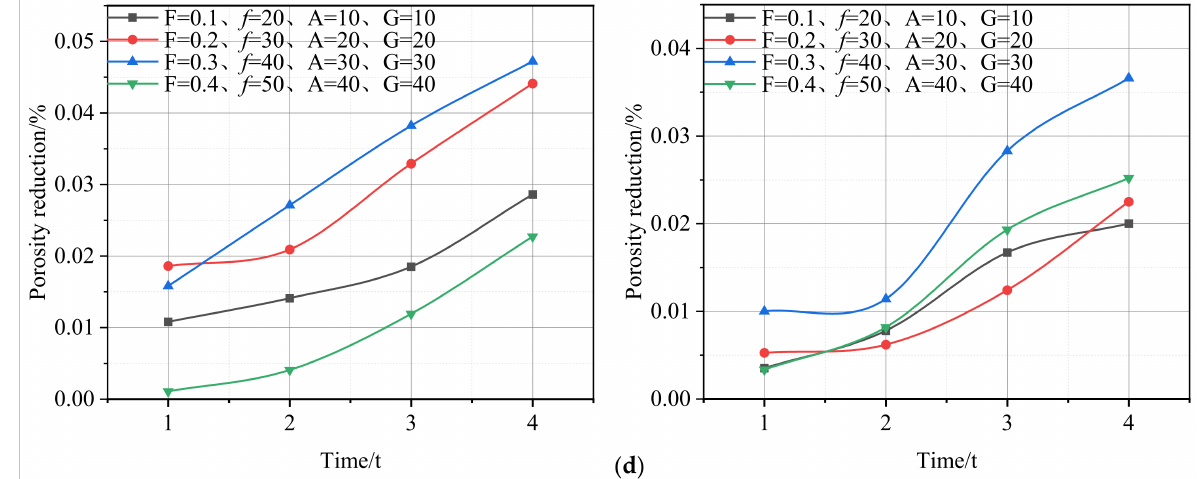
Figure 12. Variation of porosity at different locations; ( a ) Porosity varies with frequency at different locations (x-axis shows the frequency, y-axis shows the porosity reduction); ( b ) Porosity varies with excitation force at different locations (x-axis shows the excitation force, y-axis shows the porosity reduction); ( c ) Porosity varies with amplitude at different locations (x-axis shows the amplitude, y-axis shows the porosity reduction); ( d ) Porosity varies with vibration time at different locations (x-axis shows the vibration time, y-axis shows the porosity